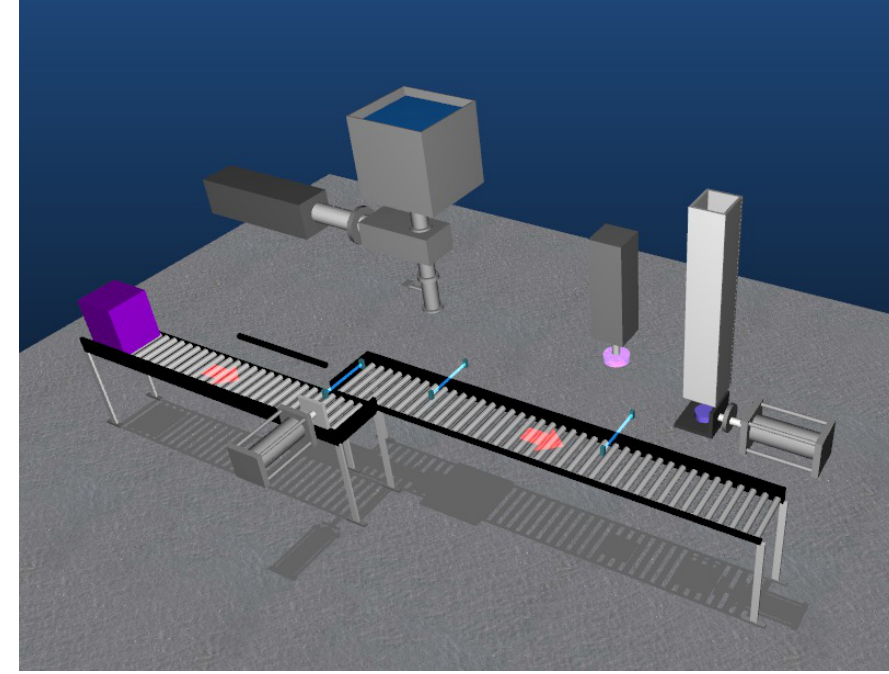
Figure 9. Experior model of the filling and encapsulating